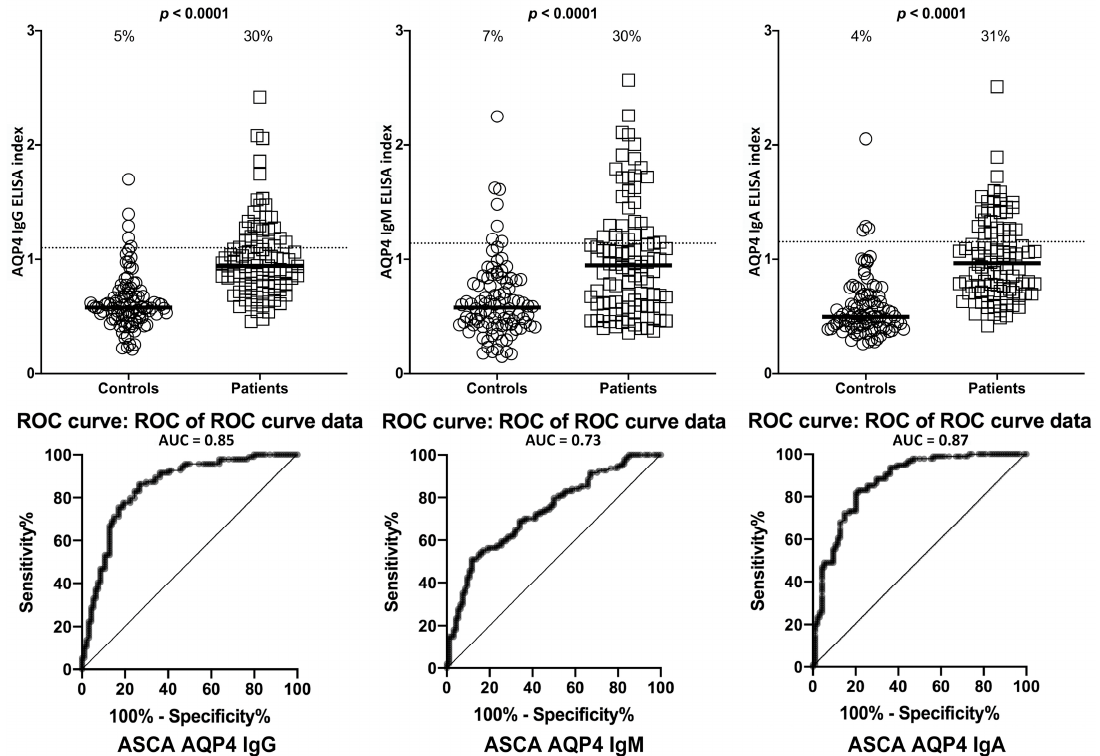
Figure 4. Percentage of elevation of IgG, IgM, and IgA antibodies against aquaporin-4 (AQP4) in 94 patients positive for ASCA and in 94 healthy controls. Dotted lines indicate the cutoff for positivity used in each assay, as calculated by ROC analysis. The percentage of elevation is indicated on top of each distribution, while bars indicate the corresponding median. The AUC for AQP4 IgG was 0.85, 0.73 for AQP4 IgM, and 0.87 for AQP4 IgA.